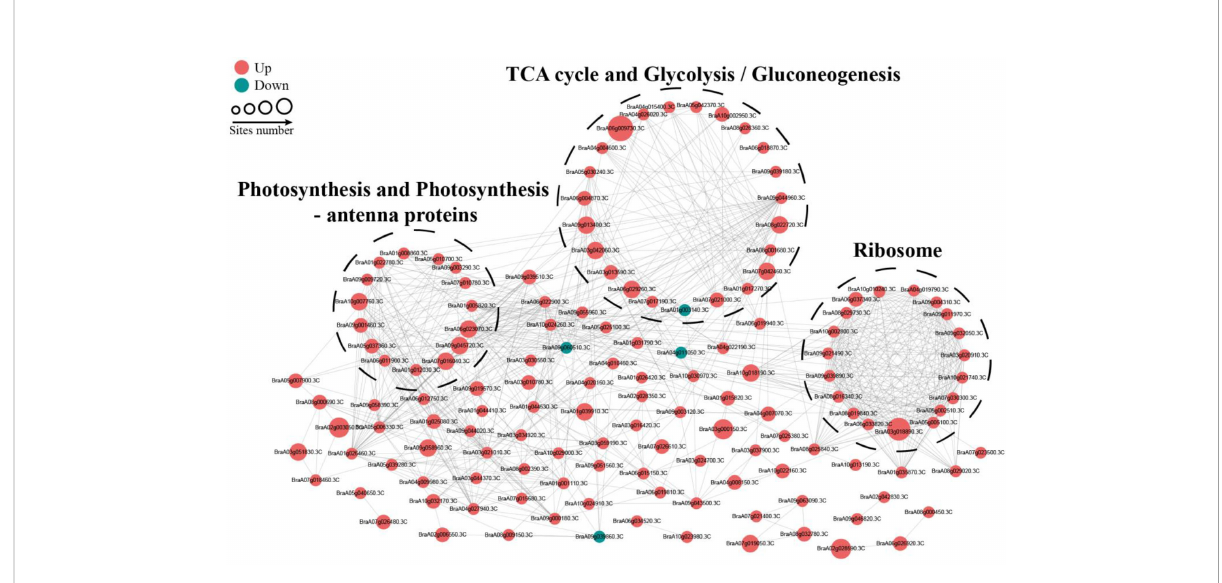
FIGURE 5 PPI network of succinylated proteins in response to OBZ